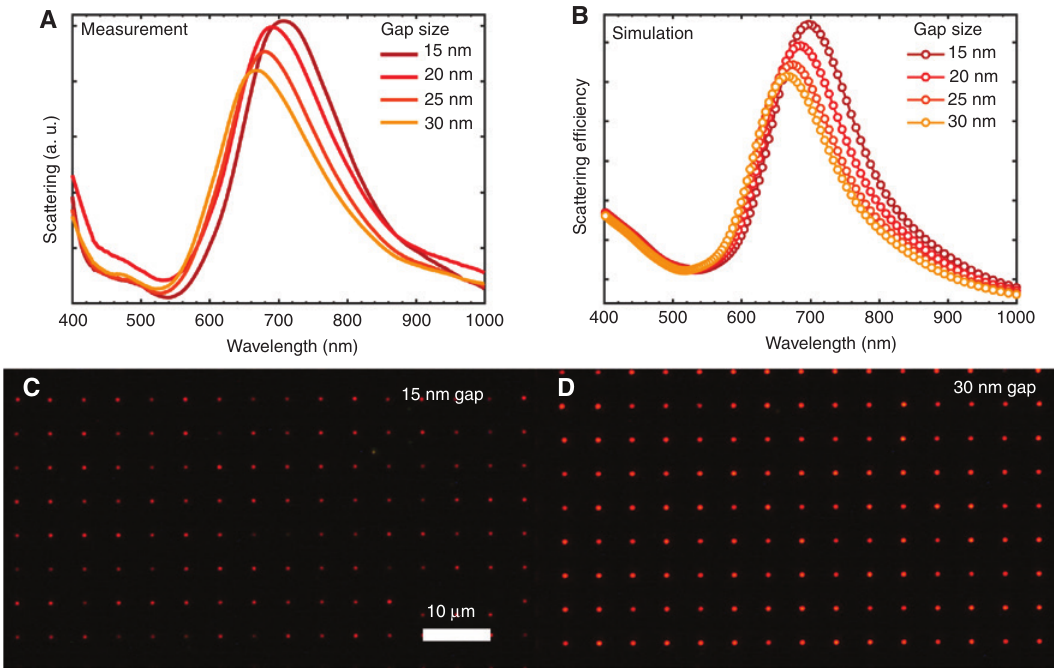
Figure 5: Gap-dependence of the plasmonic resonance for 120 nm diameter nanoantennas on 240 nm tall nanopillars. (A) Measured scattering spectra, displaying a clear blueshifting of the resonance with increasing gap. (B) Simulation of the spectra shown in (A). The large agreement shows the uniformity and precise gap definition of the samples. (C) Dark-field images of an array with 15 nm gap, where the slight differences in color can be observed due to the small gap being close to the limit of EBL. (D) Same as in (C) for a gap of 30 nm, showing a much larger uniformity due to the larger gap